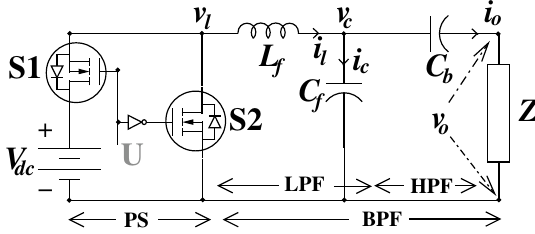
Figure 2. Output stage of audio amplifier.